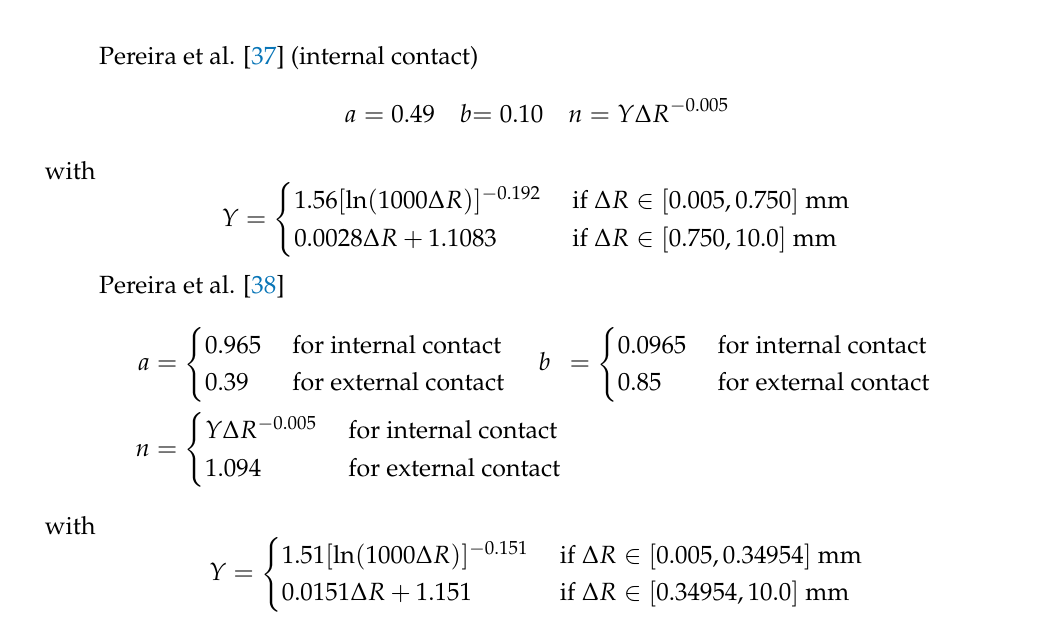
Table 2. Polynomial version of Radzimovsky’s [31] contact force model (Steel).